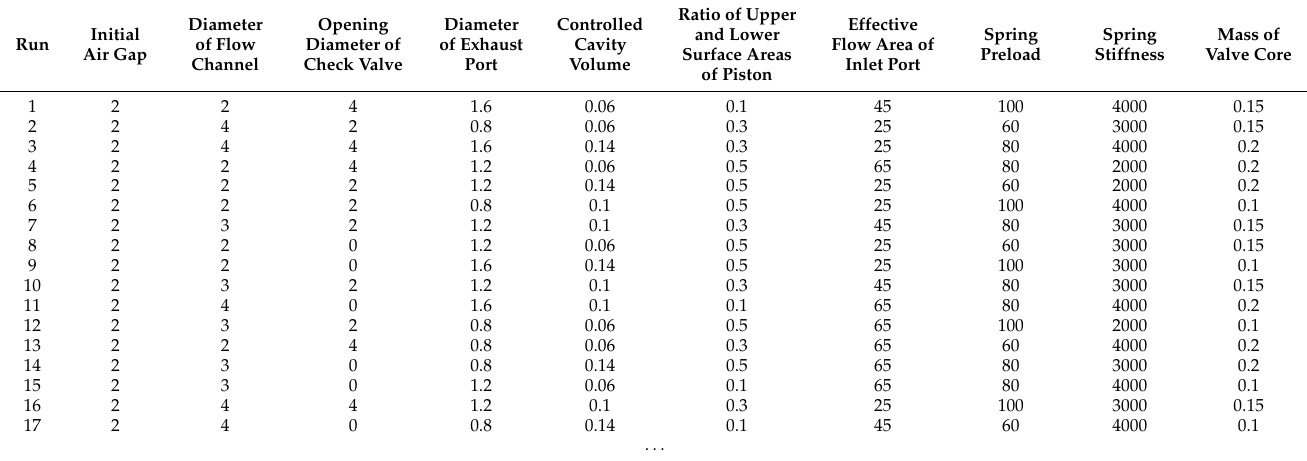
Table 4. Design of experiments based on RSM.